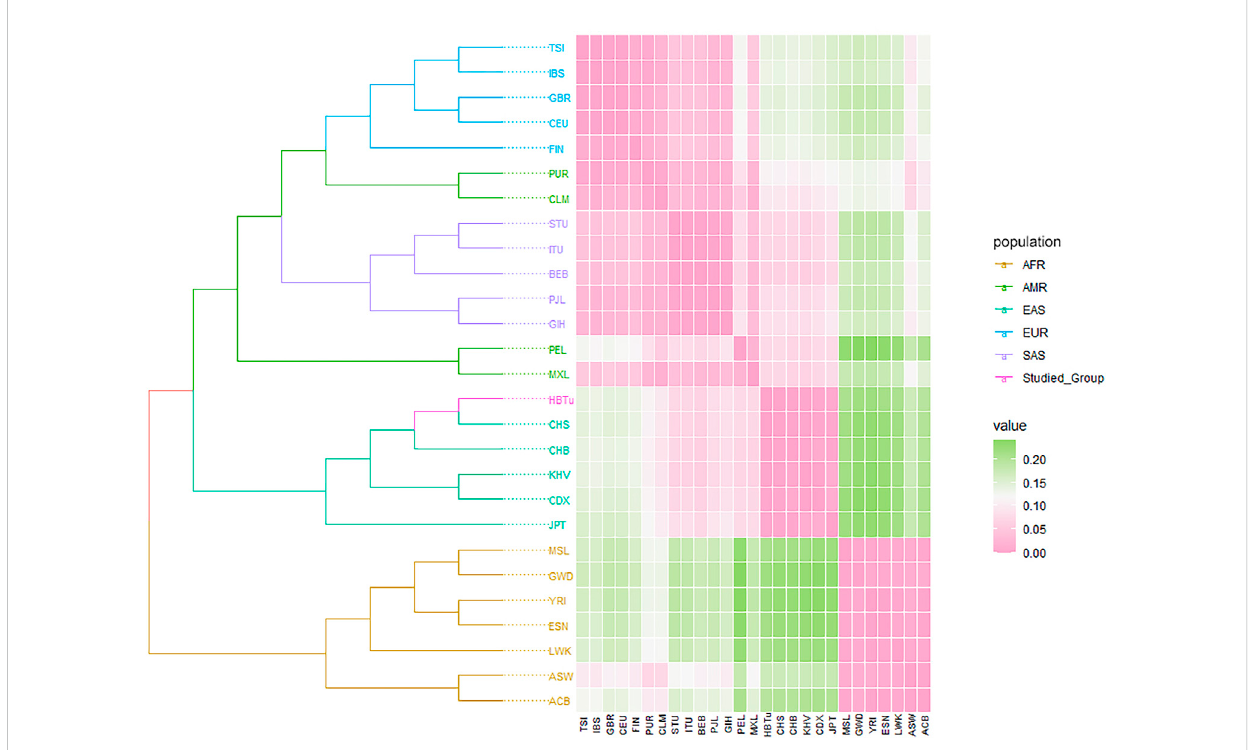
FIGURE 6 Phylogenetic tree based on pairwise D A genetic distances, and F ST heatmap of the studied Tujia group and 26 reference